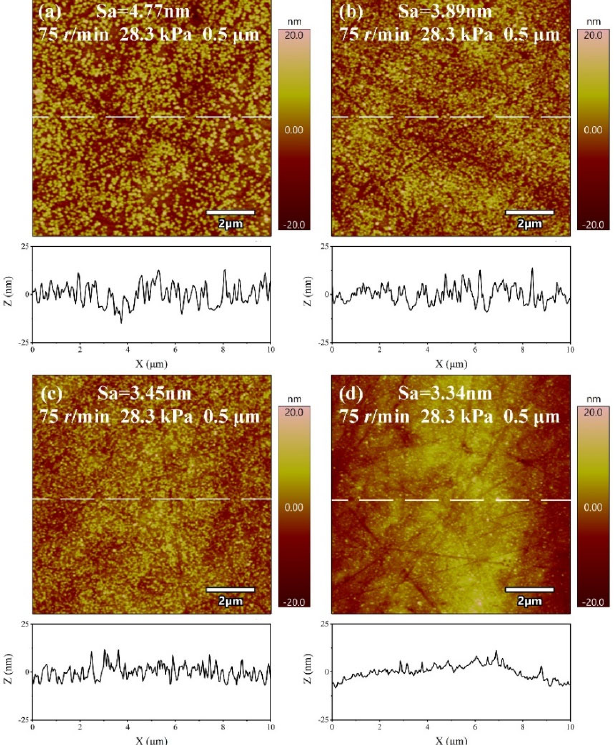
Figure 8. AFM images of amorphous alloy surfaces after polishing experiments with different H 2 O 2 concentrations. ( a ) 0 wt.%; ( b ) 0.09 wt.%; ( c ) 0.21 wt.%; ( d ) 0.3 wt.%.